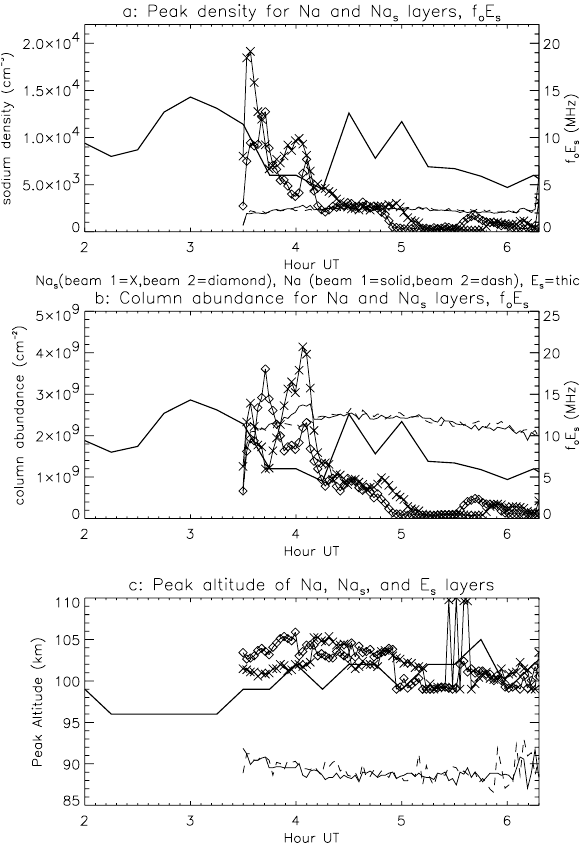
Fig. 3. (a) Peak sodium density for the sporadic and normal layers for beam 1 (x) and beam 2 (diamonds). The thick line is f o E s . (b) Same as (a) for column abundance. (c) same as (a) for peak